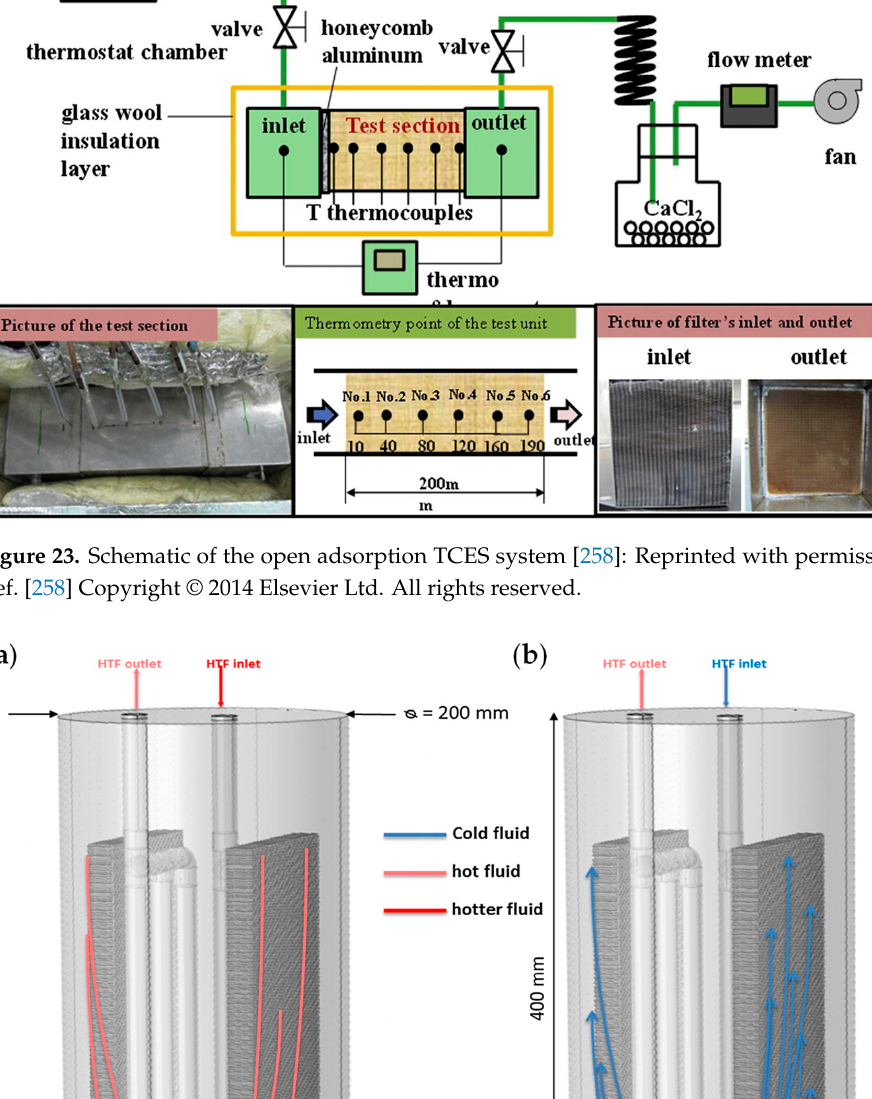
Figure 22. Schematic of the geometry of the bed: (a) TCM energy storage system, (b) side view of honeycomb heat exchanger fi lled with TCM, (c) computational domain [257]: Reprinted with per- mission from Ref. [257] Copyright © 2021 Elsevier Ltd. All rights reserved.